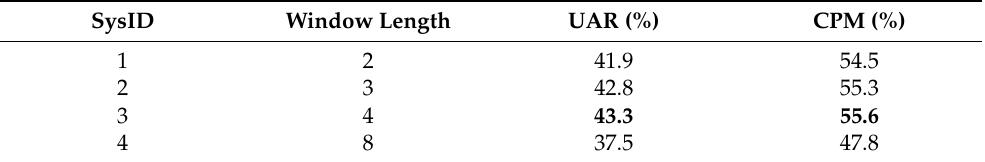
Table 2. The experimental results on the temporal window length selection on the AffWild2 vali- dation set. VGGFace-EE was used as the embeddings extractor; SVM was used as a classifier on suprasegmental features. The best result within the column is highlighted in bold. SysID Window Length